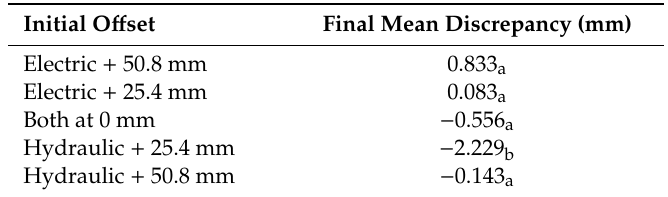
Table 3. LSD comparison of final discrepancy between the electric and hydraulic actuator starting from the minimum stroke (0 mm), while blocking for